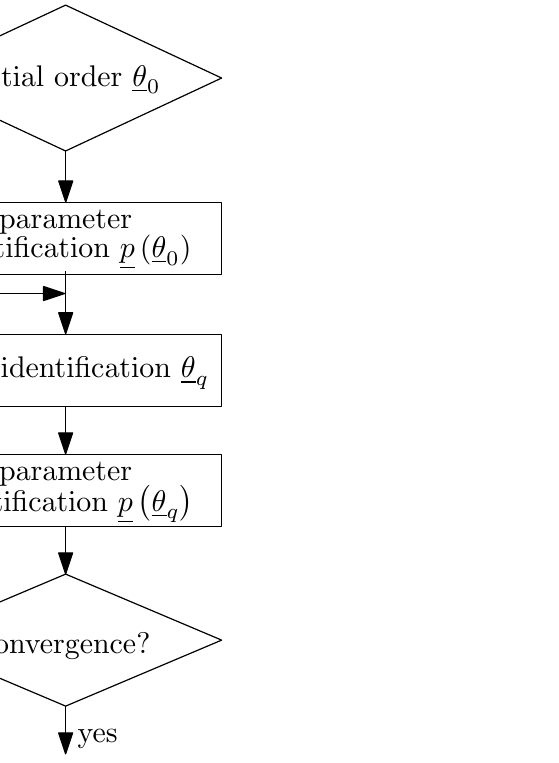
Figure 1. Iterative method for simultaneous parameter and order identification of a fractional